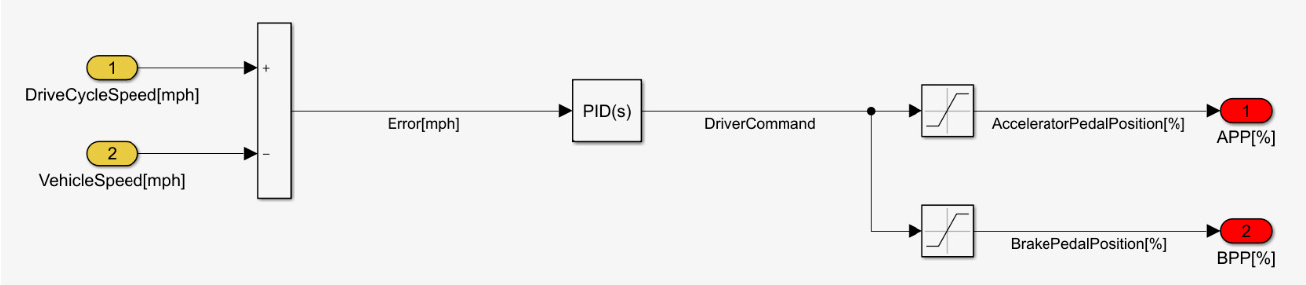
Figure 8. Driver control system block Adapted from [16], MathWorks: 2020.